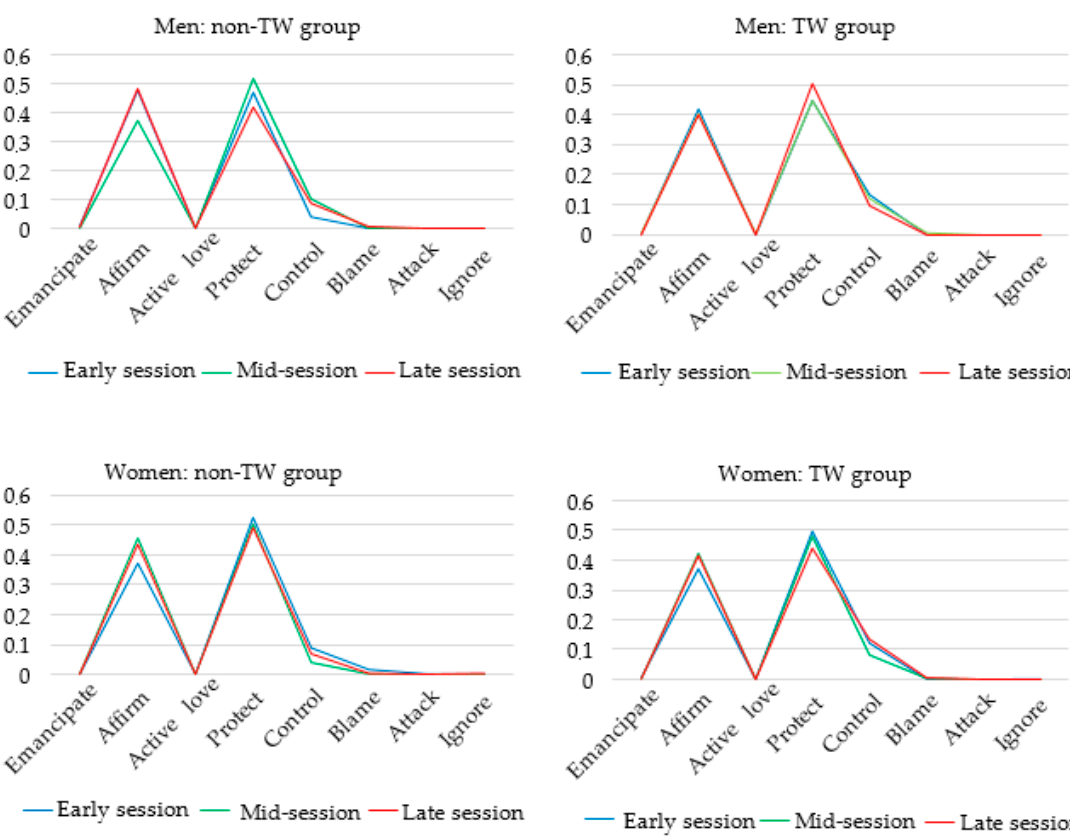
Figure 2. The four plots represent therapist SASB cluster scores in each subgroup. Blue line: session early in the treatment, green line: mid-treatment, red line: late phase of treatment. SASB clusters along the x-axis and the SASB the proportion of cluster scores (ranging from 0–1) on the y-axis.